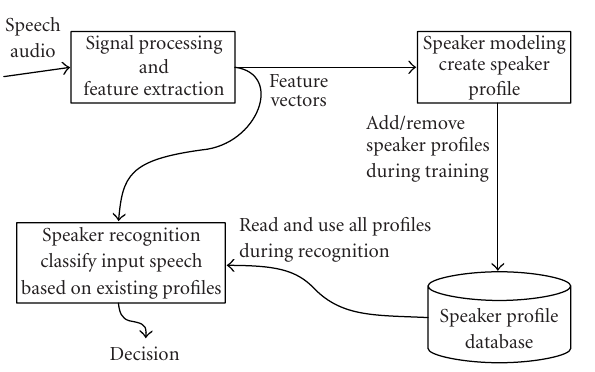
Figure 1: Closed-set speaker identification system.